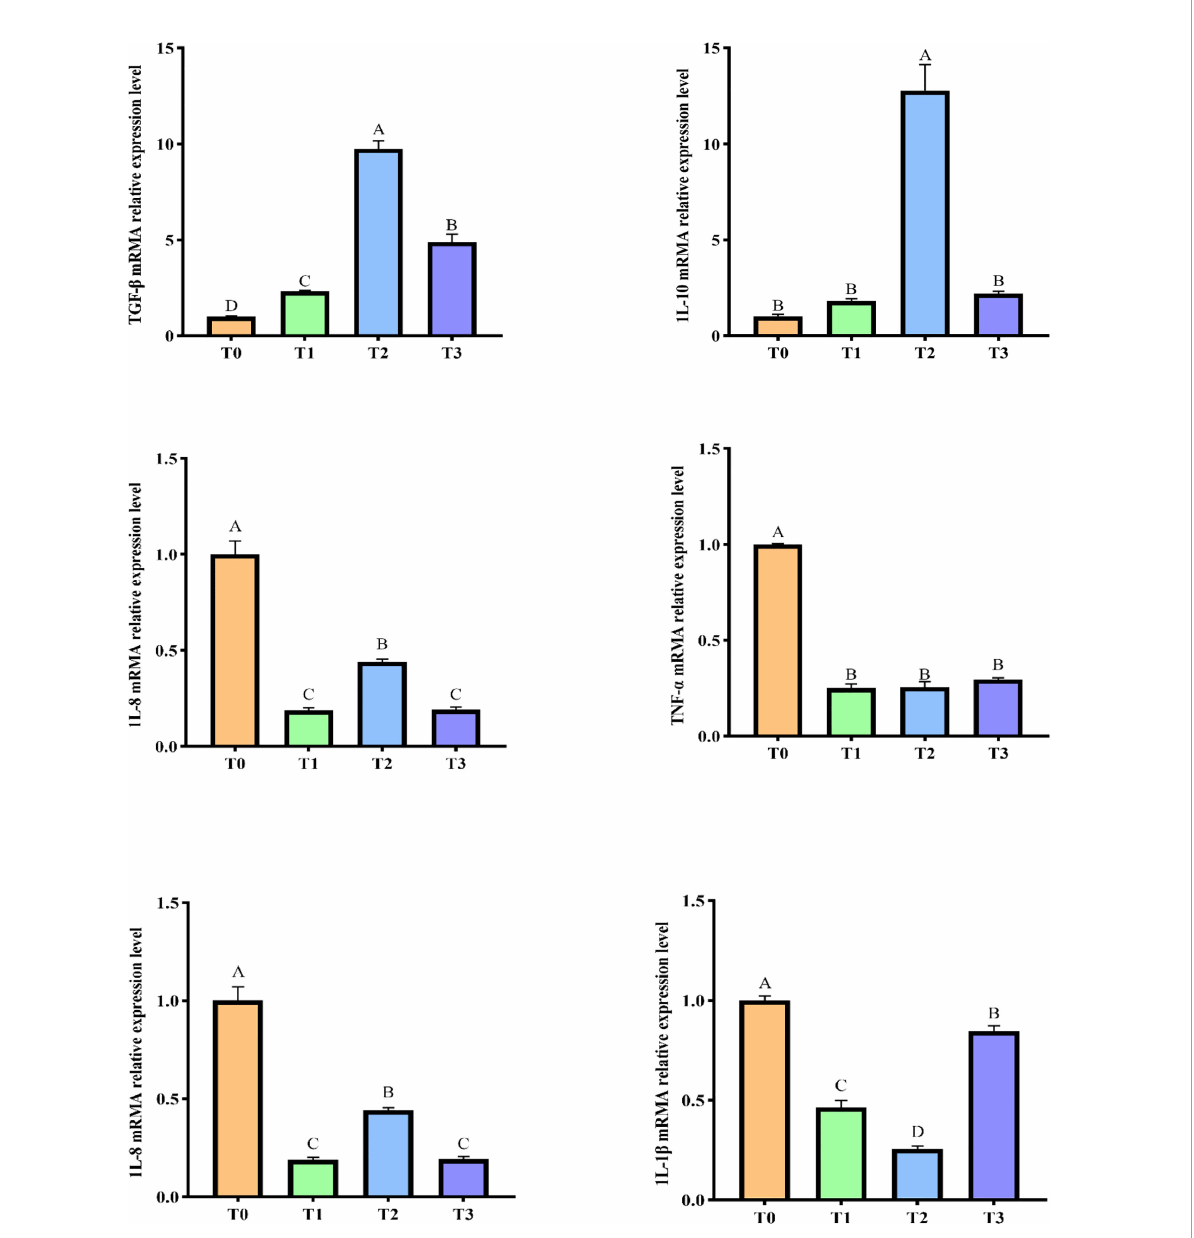
FIGURE 3 Effect of feeding FT on the expression of in fl ammatory factors in the intestine of largemouth bass after infection with A.hydrophila . Different letters indicate signi fi cant differences ( P < 0.05 ); Values are presented as mean ± SD (n =5). IL-1 b : interleukin-1 b ; IL-8: interleukin-8; IL-10: interleukin-10; IL-15: interleukin-15; TNF- a : tumor necrosis factor- a ; TG F- b 1: transforming growth factor- b